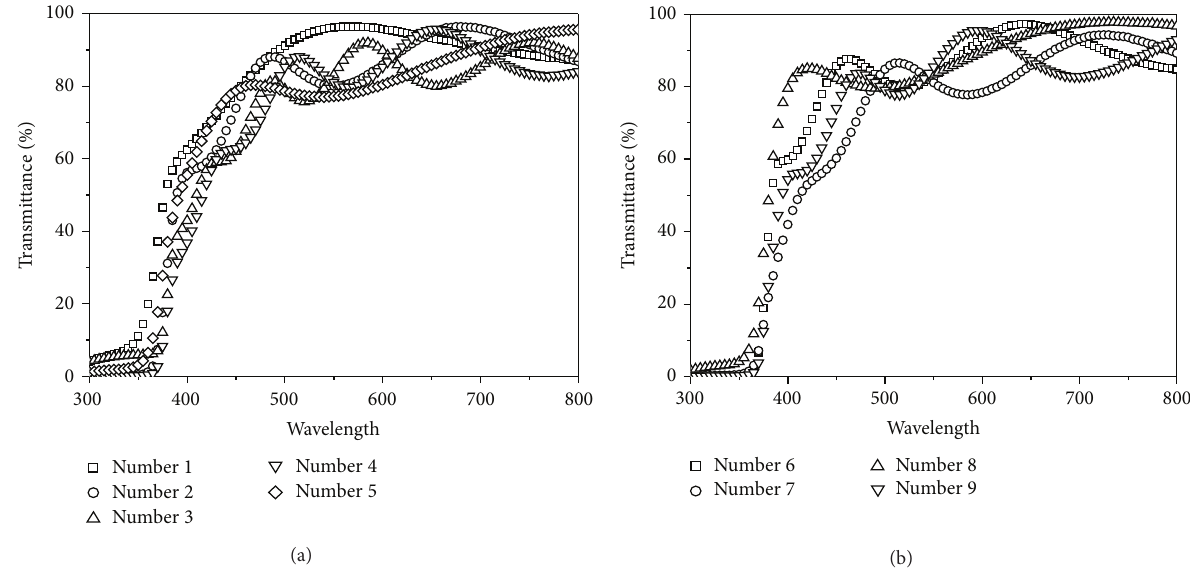
Figure 2: The optical transmittance of the deposited ZnO thin films as a function of wavelength; (a) experiments number 1 ∼ 5 and (b) experiments number 6 ∼ 9.